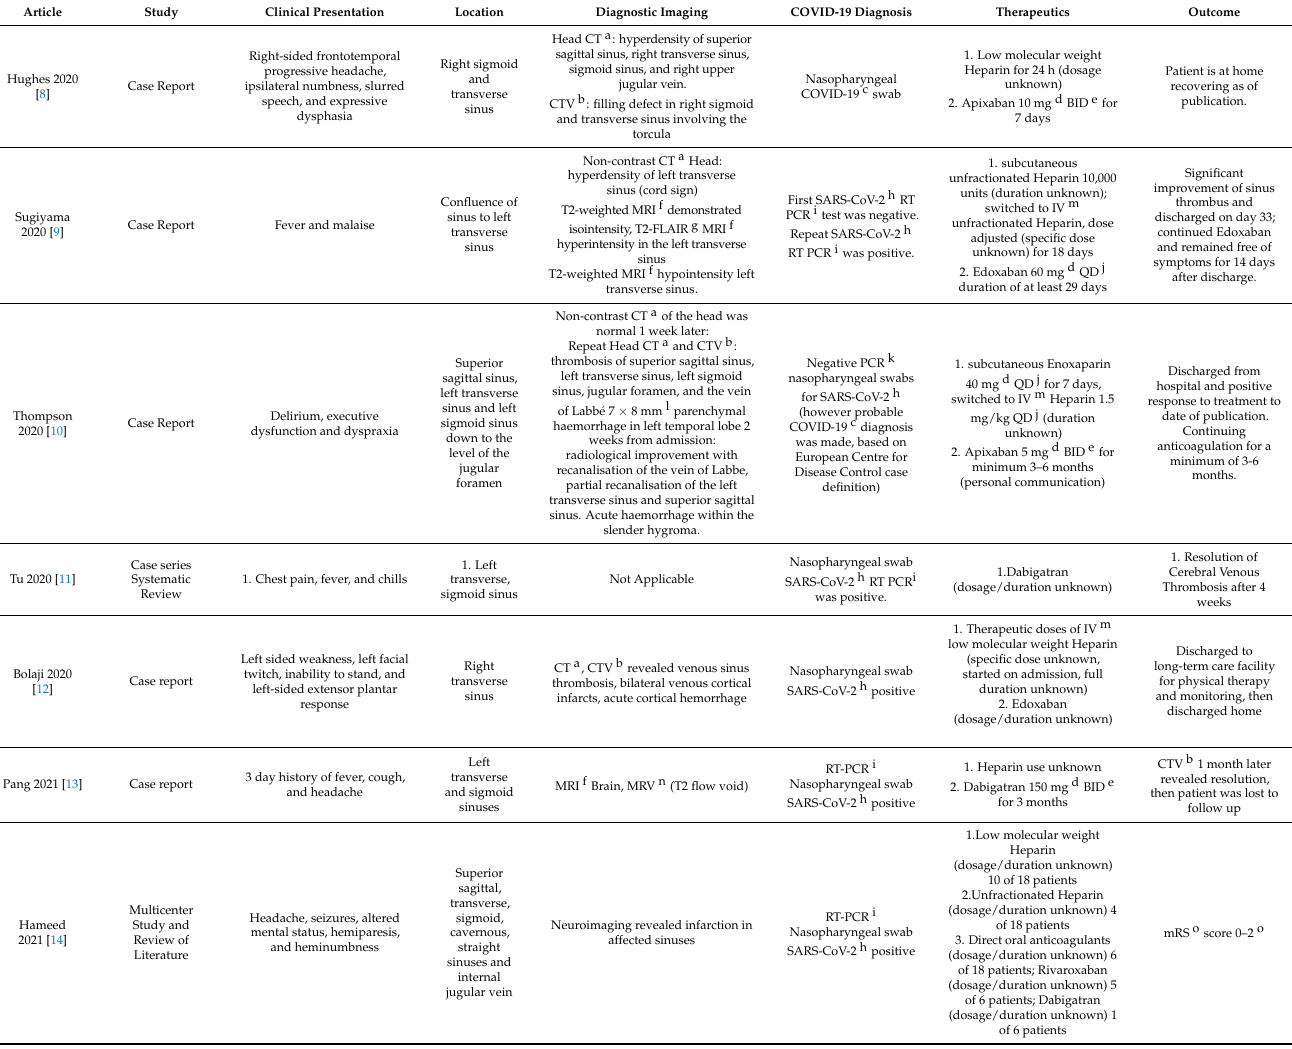
Table 1. Review of literature: cases involving cerebral venous thrombosis with COVID-19 that only used Direct Oral Anticoagulants for